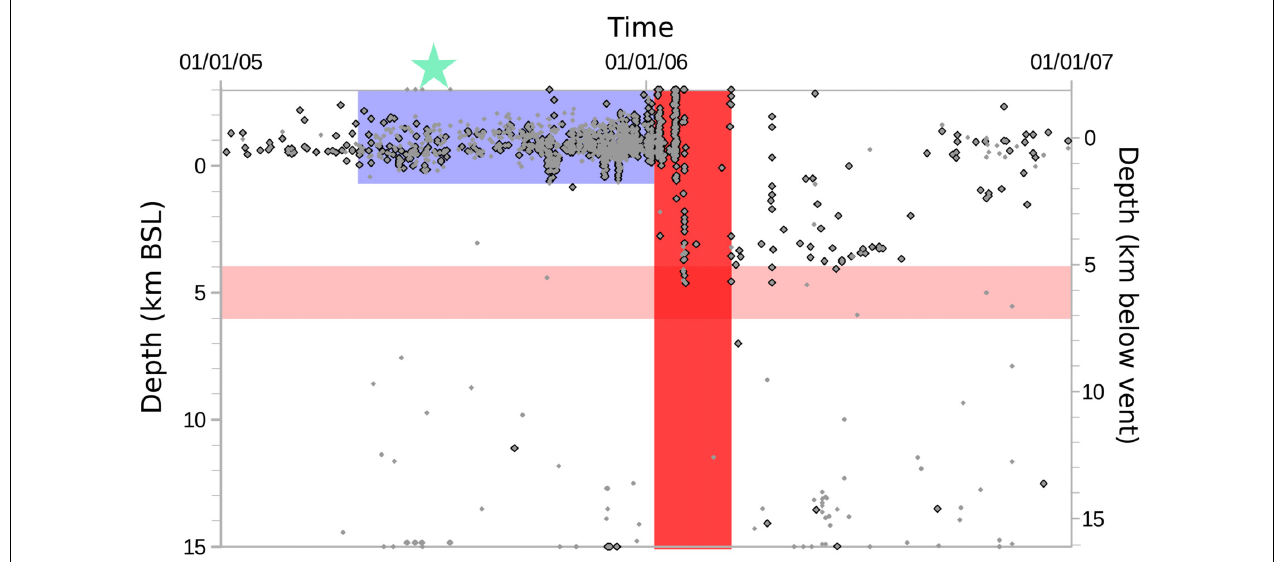
FIGURE 5 | Time-depth plot for Augustine Volcano, Alaska from January 2005 to December 2006. Light red – petrologically-defined magma source. Dark red – eruptions. Light blue shading shows the timing and depth of precursory seismicity. Gray dots show all earthquakes and black outlined dots show earthquakes with well-constrained locations. Green star indicates onset of GPS-detected